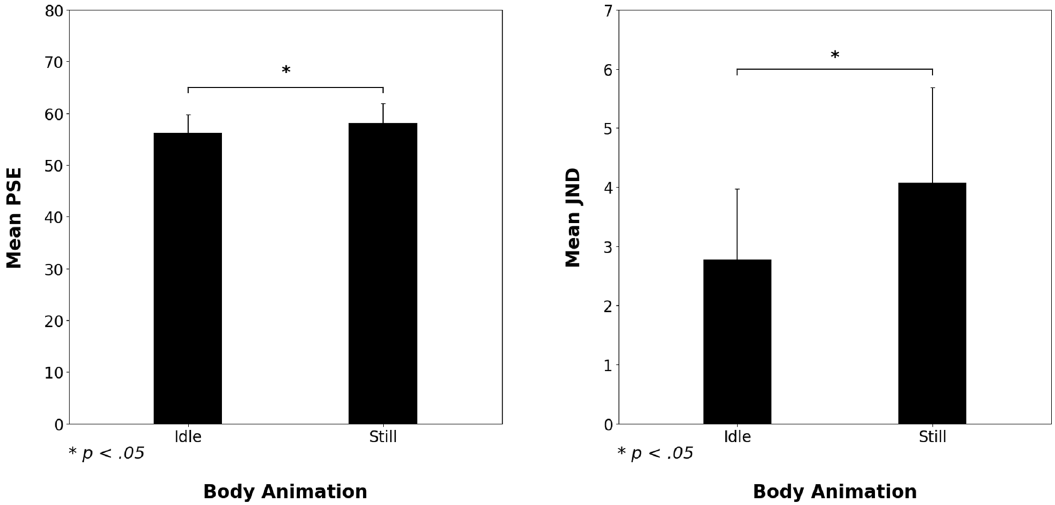
Figure 3. Mean of PSE and JND obtained from the logistic modelling of each participant’s “Very Intense Pain” responses in the still and idle conditions . Error bars correspond to confidence intervals at